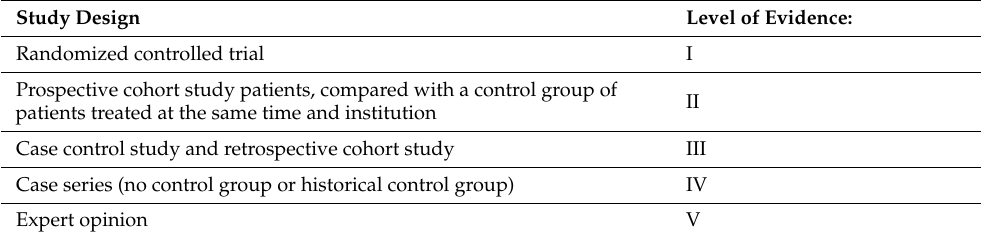
Table 1. Levels of evidence criteria